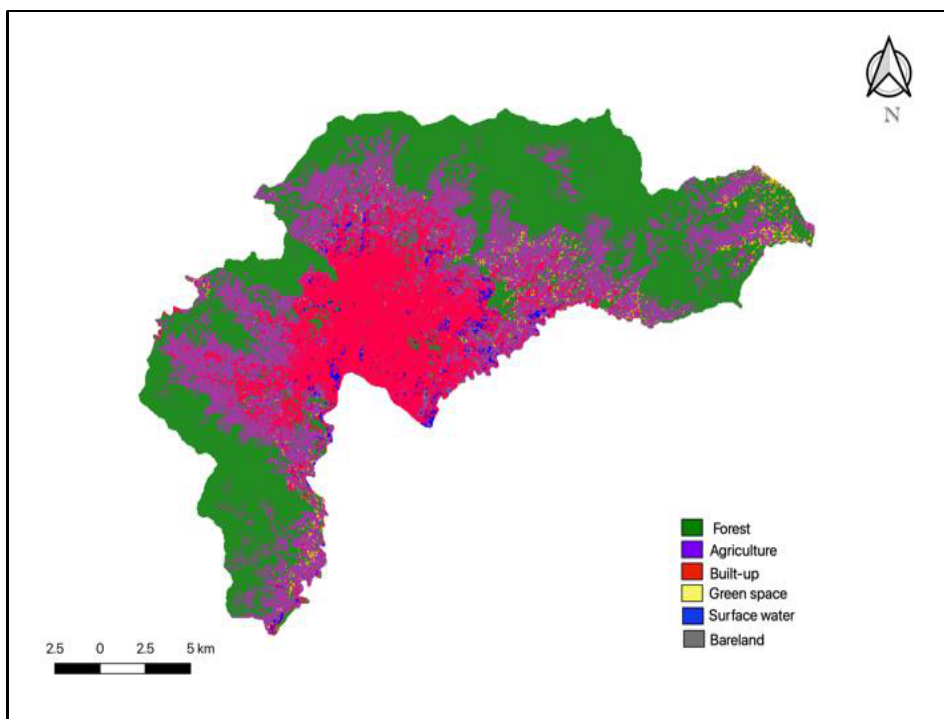
Figure 4. Land cover map for year 2011.